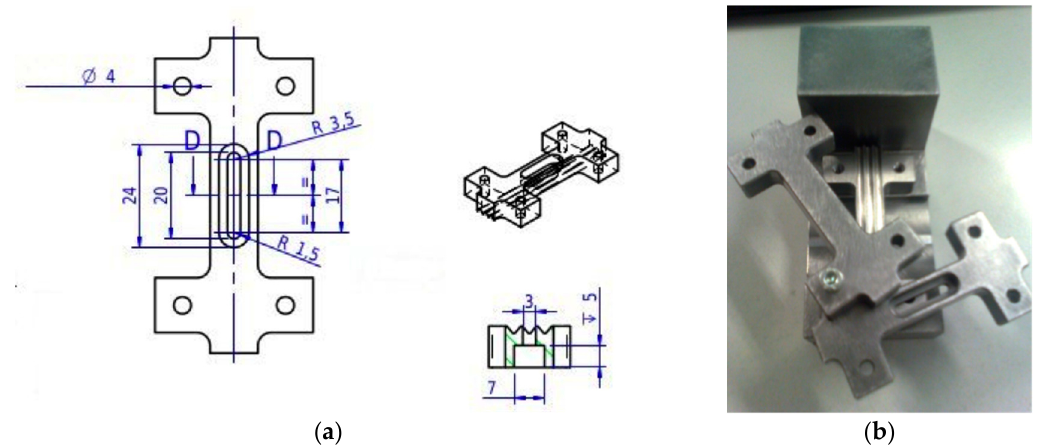
Figure 2. CAD design ( a ) and image ( b ) of the modified jig for compression tests.